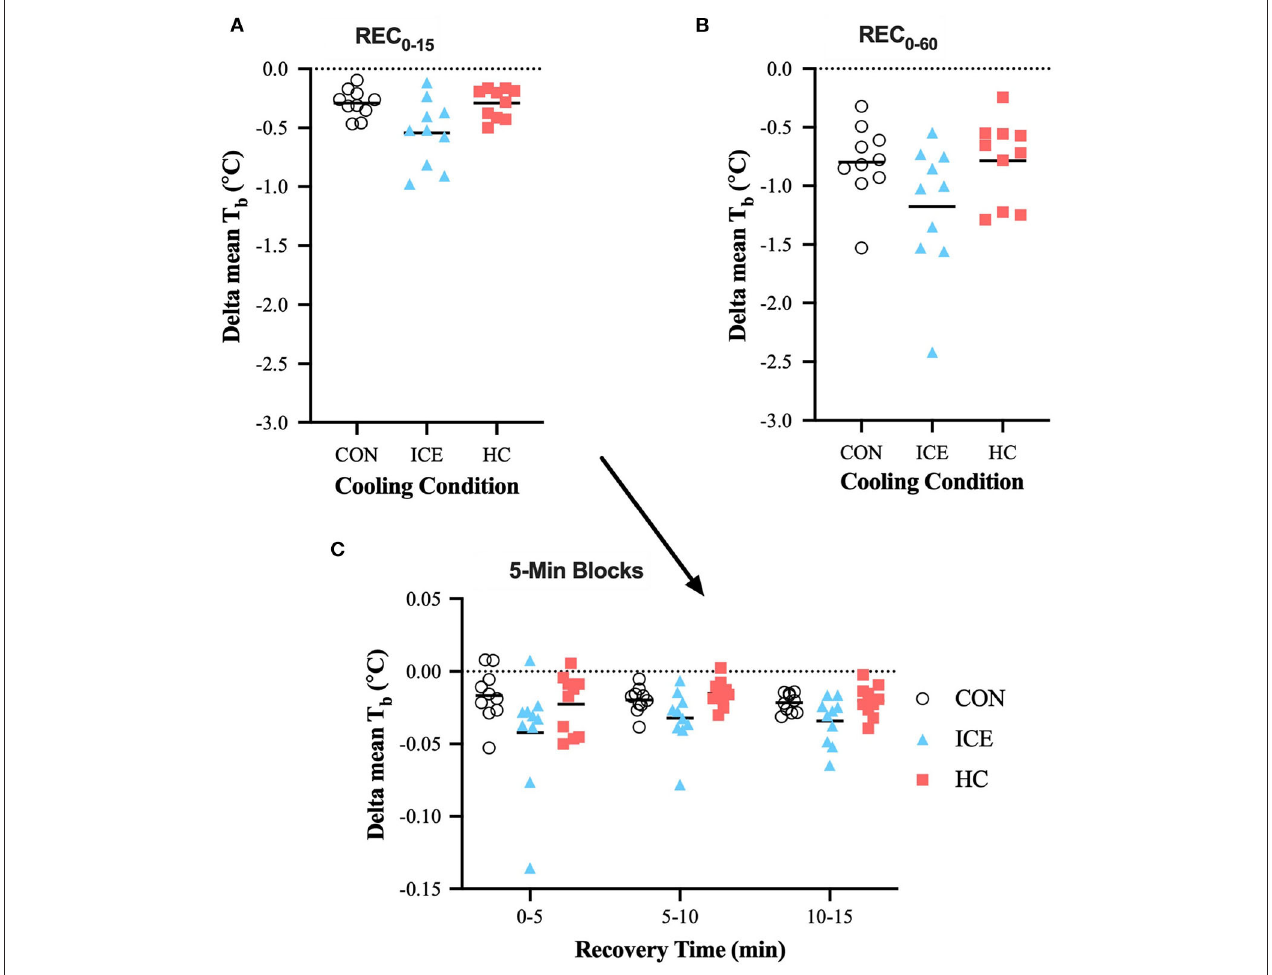
FIGURE 4 | Mean (bar) and individual delta mean body temperature (T b ) during REC 0 − 15 (A) , REC 0 − 60 (B), and 5-min blocks during REC 0 − 15 (C) when using ice vest (ICE), single-hand cooling (HC), and non-cooled control (CON) during heated exercise